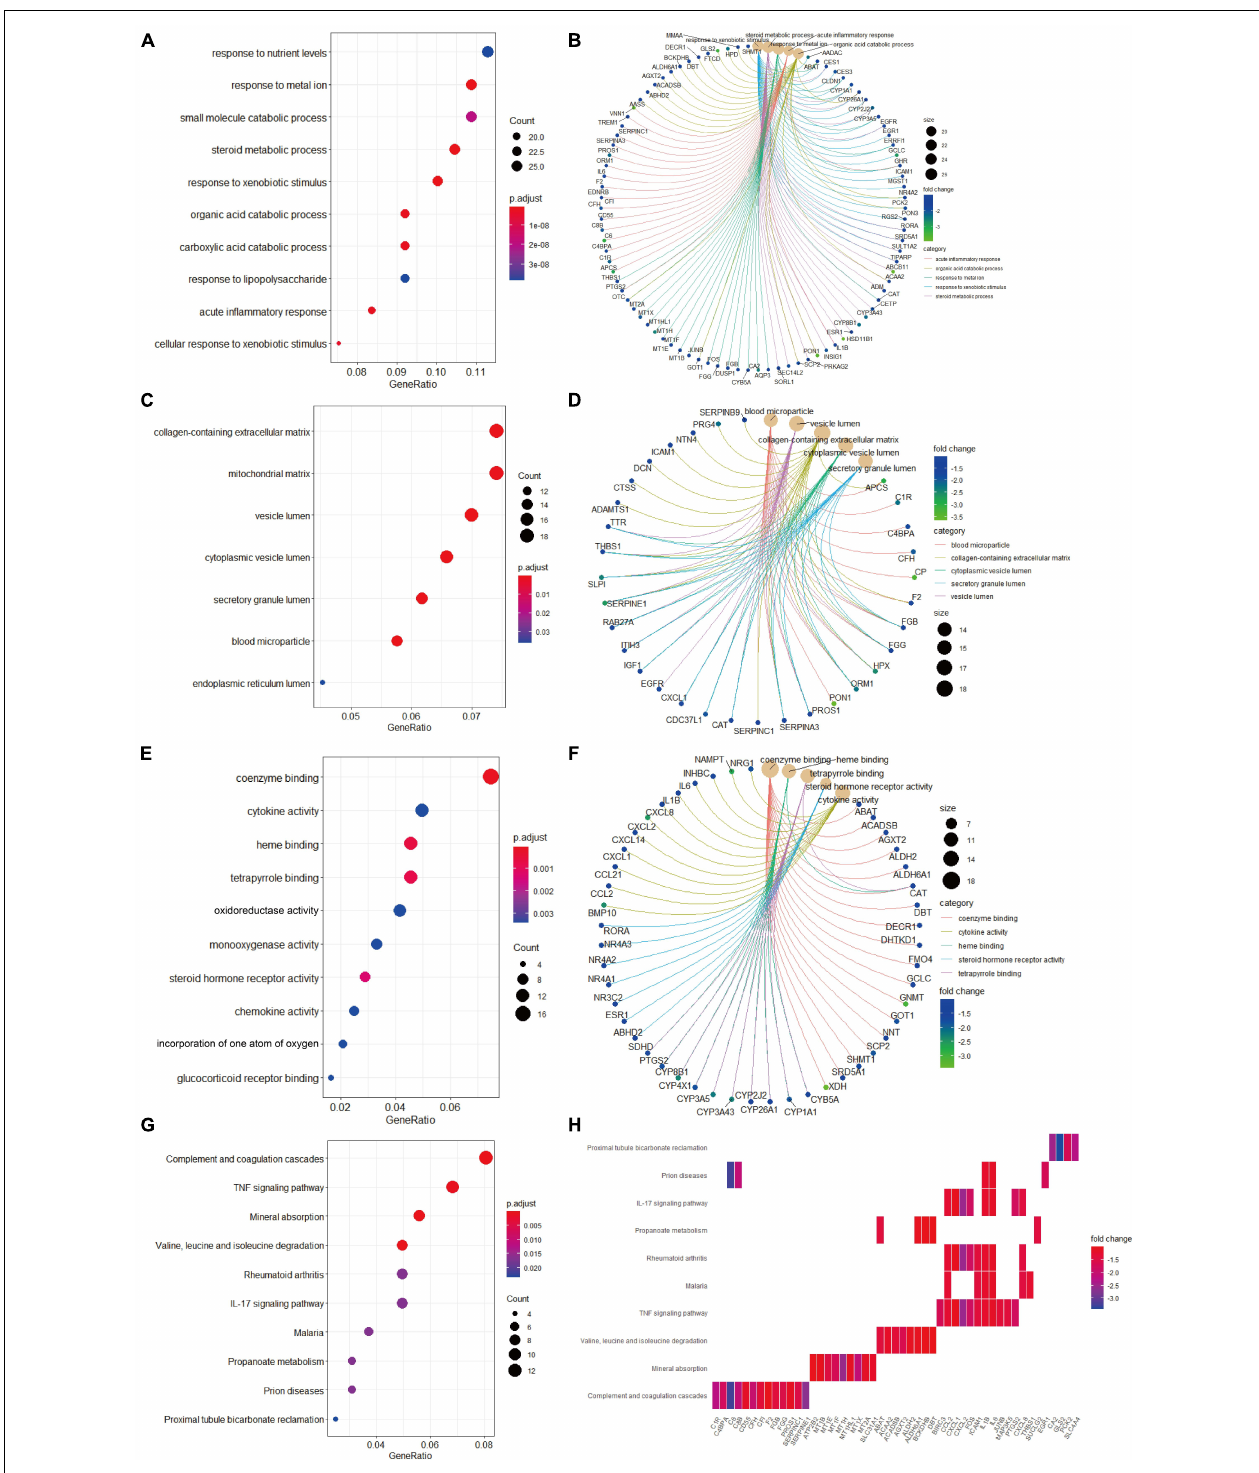
FIGURE 4 | Gene Ontology terms and KEGG pathway enrichment analyses of the downregulated candidate genes. (A) The enriched GO-BP terms based on downregulated candidate genes. (B) The downregulated candidate genes and their enriched GO-BP terms. (C) The enriched GO-CC terms based on downregulated candidate genes. (D) The downregulated candidate genes and their enriched GO-CC terms. (E) The enriched GO-MF terms based on downregulated candidate genes. (F) The downregulated candidate genes and their enriched GO-MF terms. (G) KEGG pathway analysis showing the enriched pathways based on downregulated candidate genes. (H) Heatmap showing specific downregulated candidate genes and their enriched pathways. BP, biological process; CC, cellular component; GO, Gene Ontology; KEGG, Kyoto Encyclopedia of Genes and Genomes; MF, molecular function.